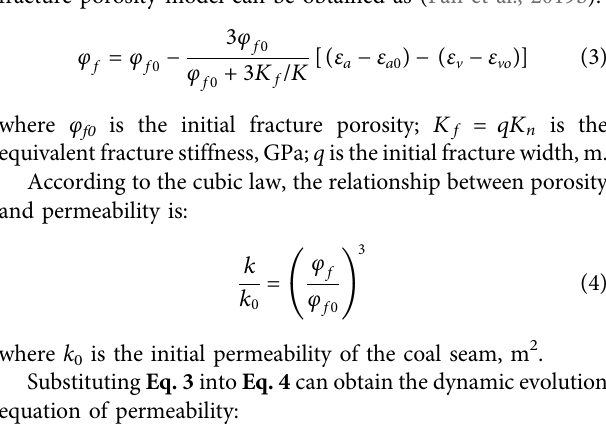
Frontiers in Earth Science |